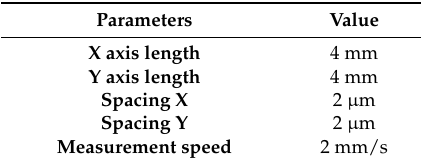
Table 3. Three-dimensional (3D) maps acquisition